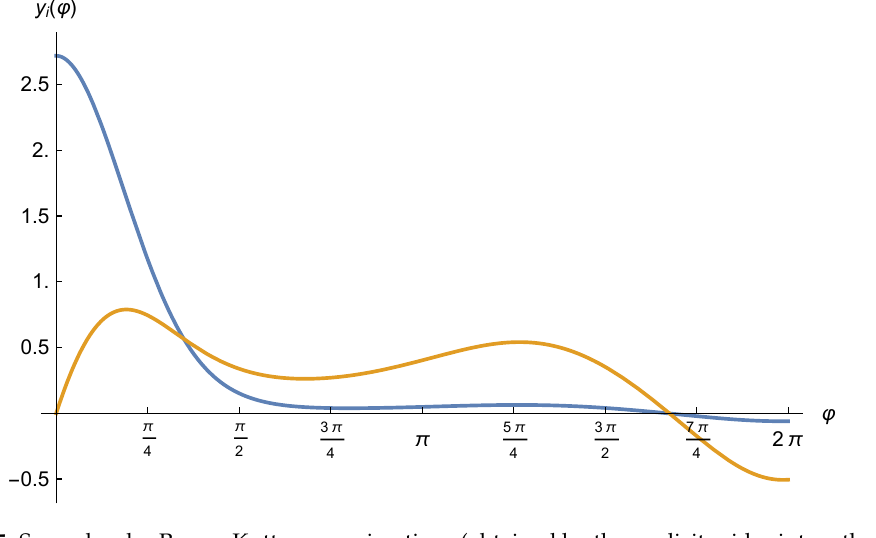
Figure 5. Second order Runge-Kutta approximations (obtained by the explicit midpoint method) to each particular solution from the reduced la Cierva’s equation, where the first particular solution, y 1 ( ϕ ) (c.f. Equation (61)), is depicted by a blue line, ϕ varies in the range [ 0,2 π ] , and the choice of parameters was as suggested by Mr. la Cierva, i.e., m = 0.5 and λ =